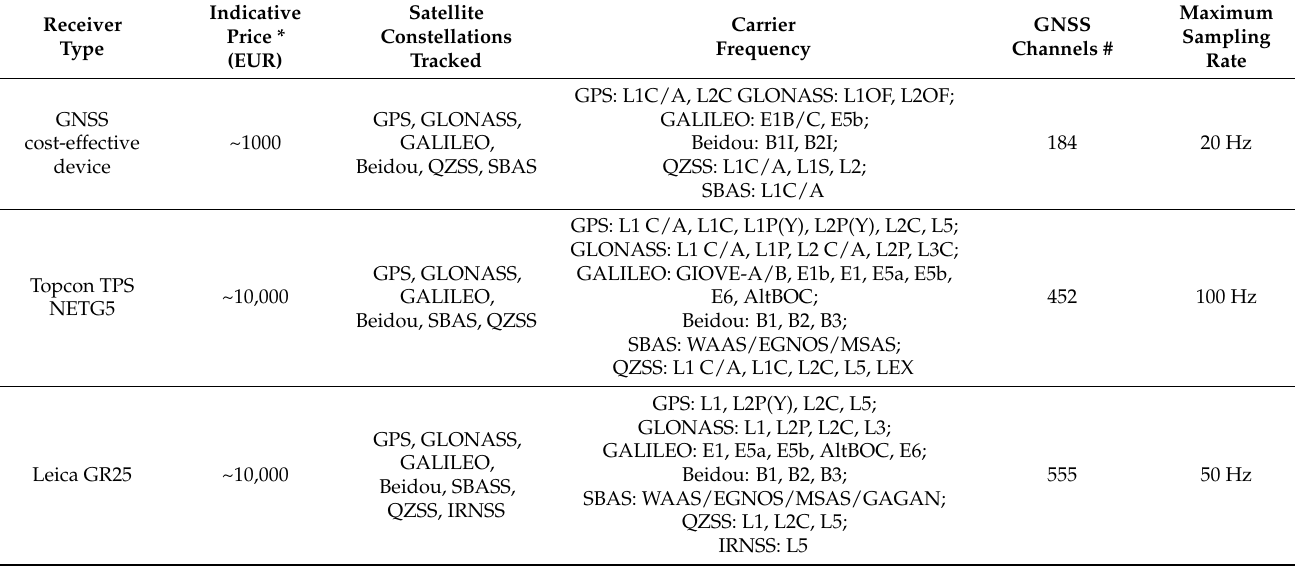
Table 1. Main characteristics of the GNSS receivers used in this